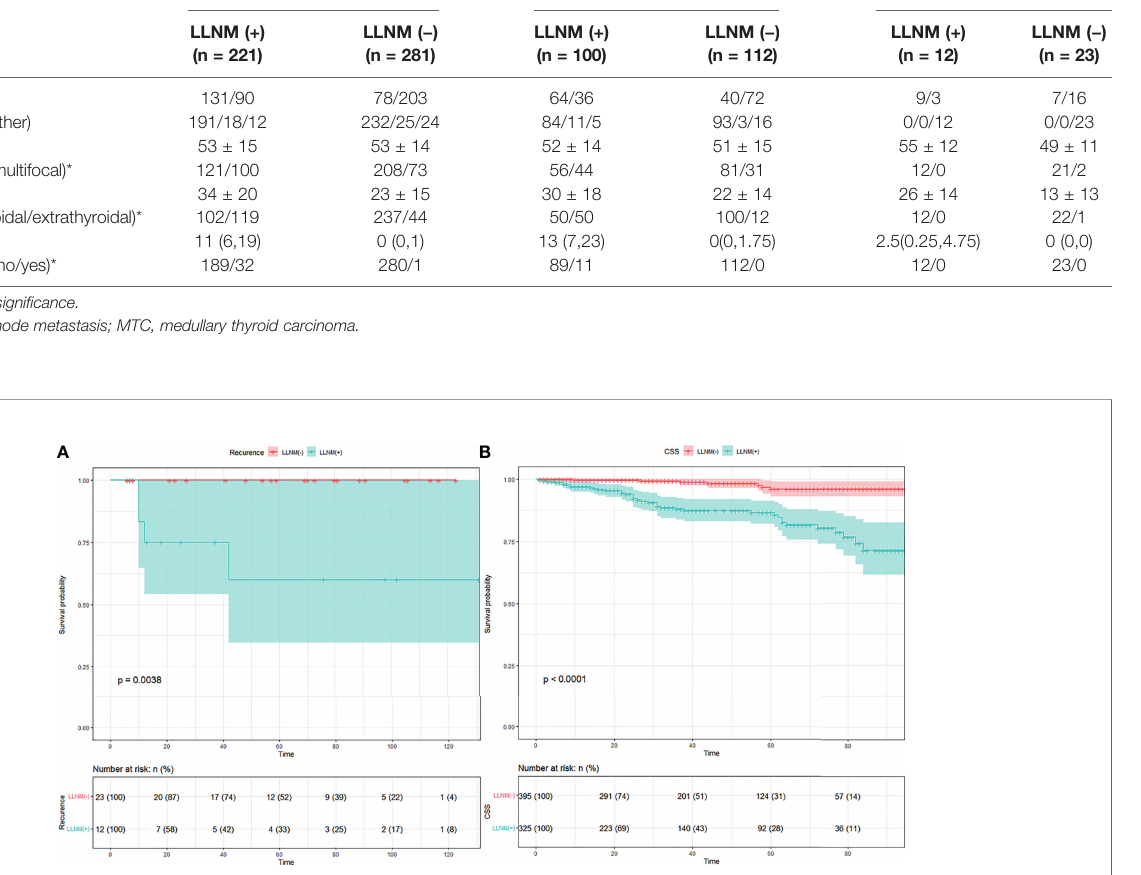
FIGURE 1 | (A) K – M curve of recurrence in MTC patients of our medical center. (B) K – M curve of cancer speci fi c survival in MTC patients of SEER